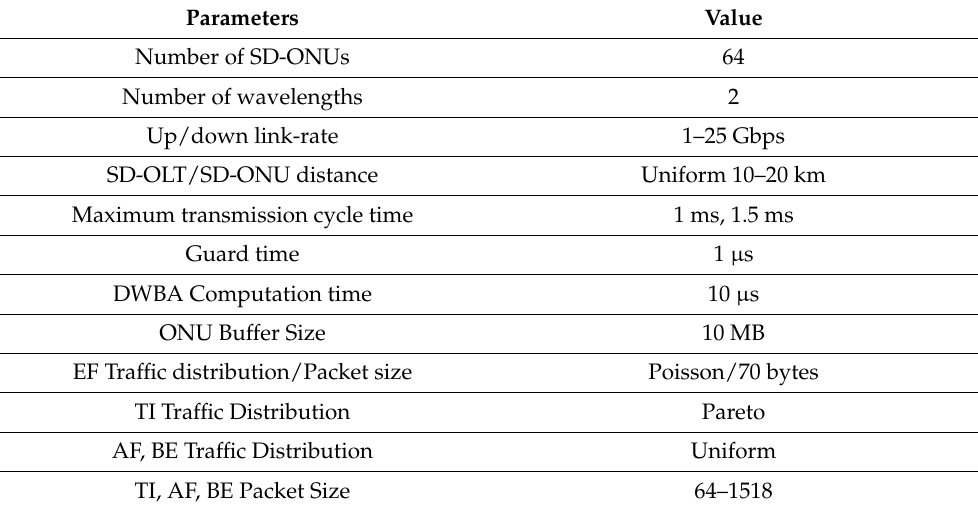
Table 1. Simulation parameters. Parameters Value Number of SD-ONUs